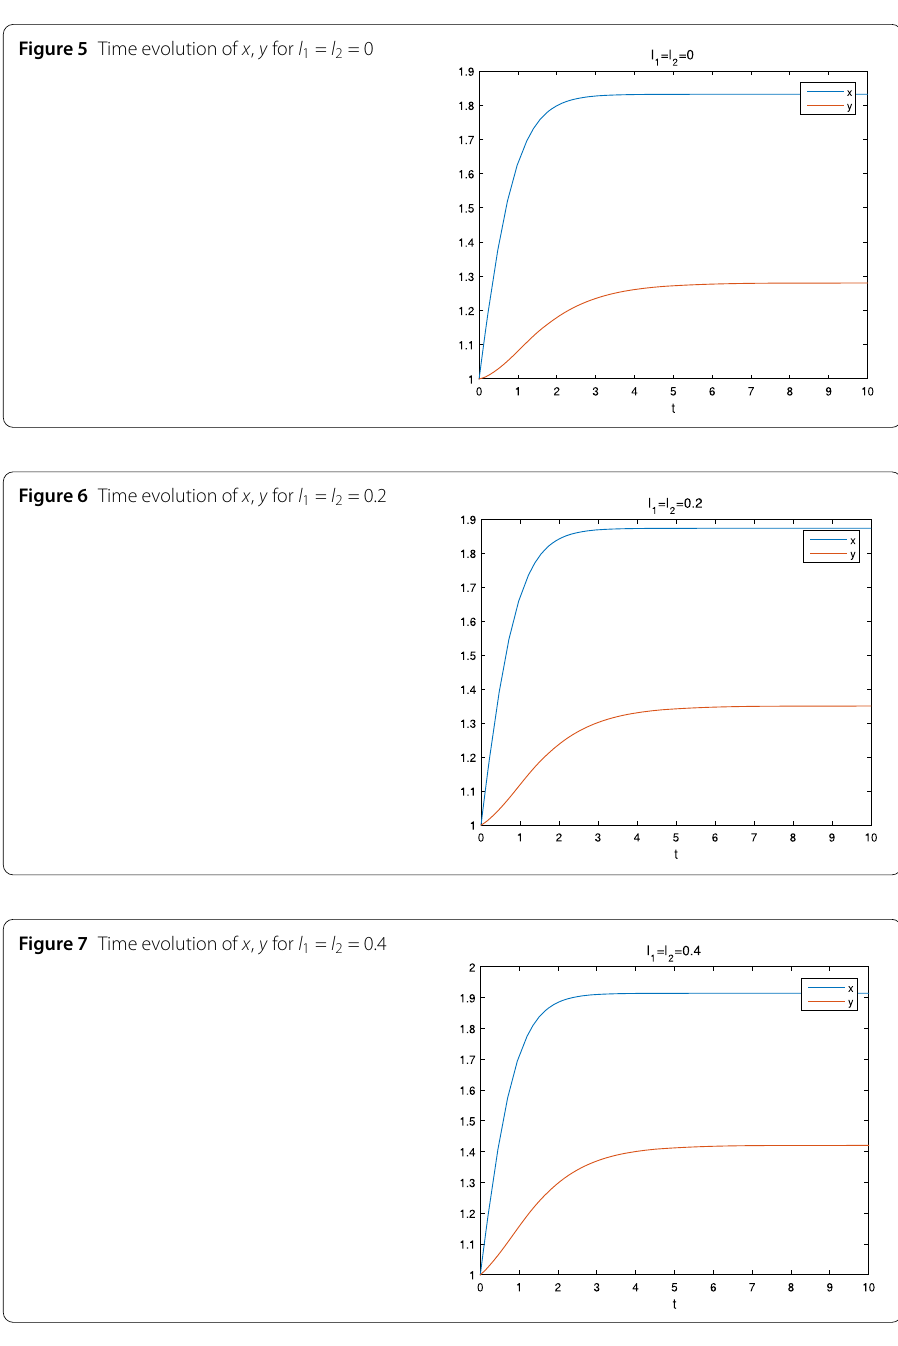
Figure 5 Time evolution of x , y for l 1 = l 2 = 0